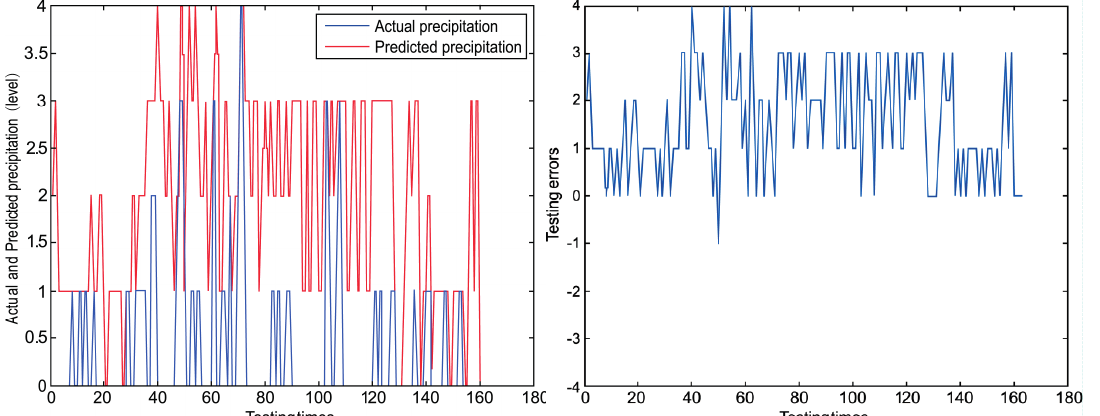
Figure 6. Testing results of